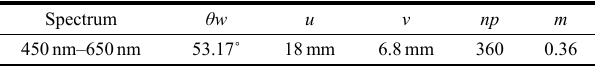
Table 2 Design parameters for multichannel spectrometer to capture the 1st order spectrum for spectral analysis.